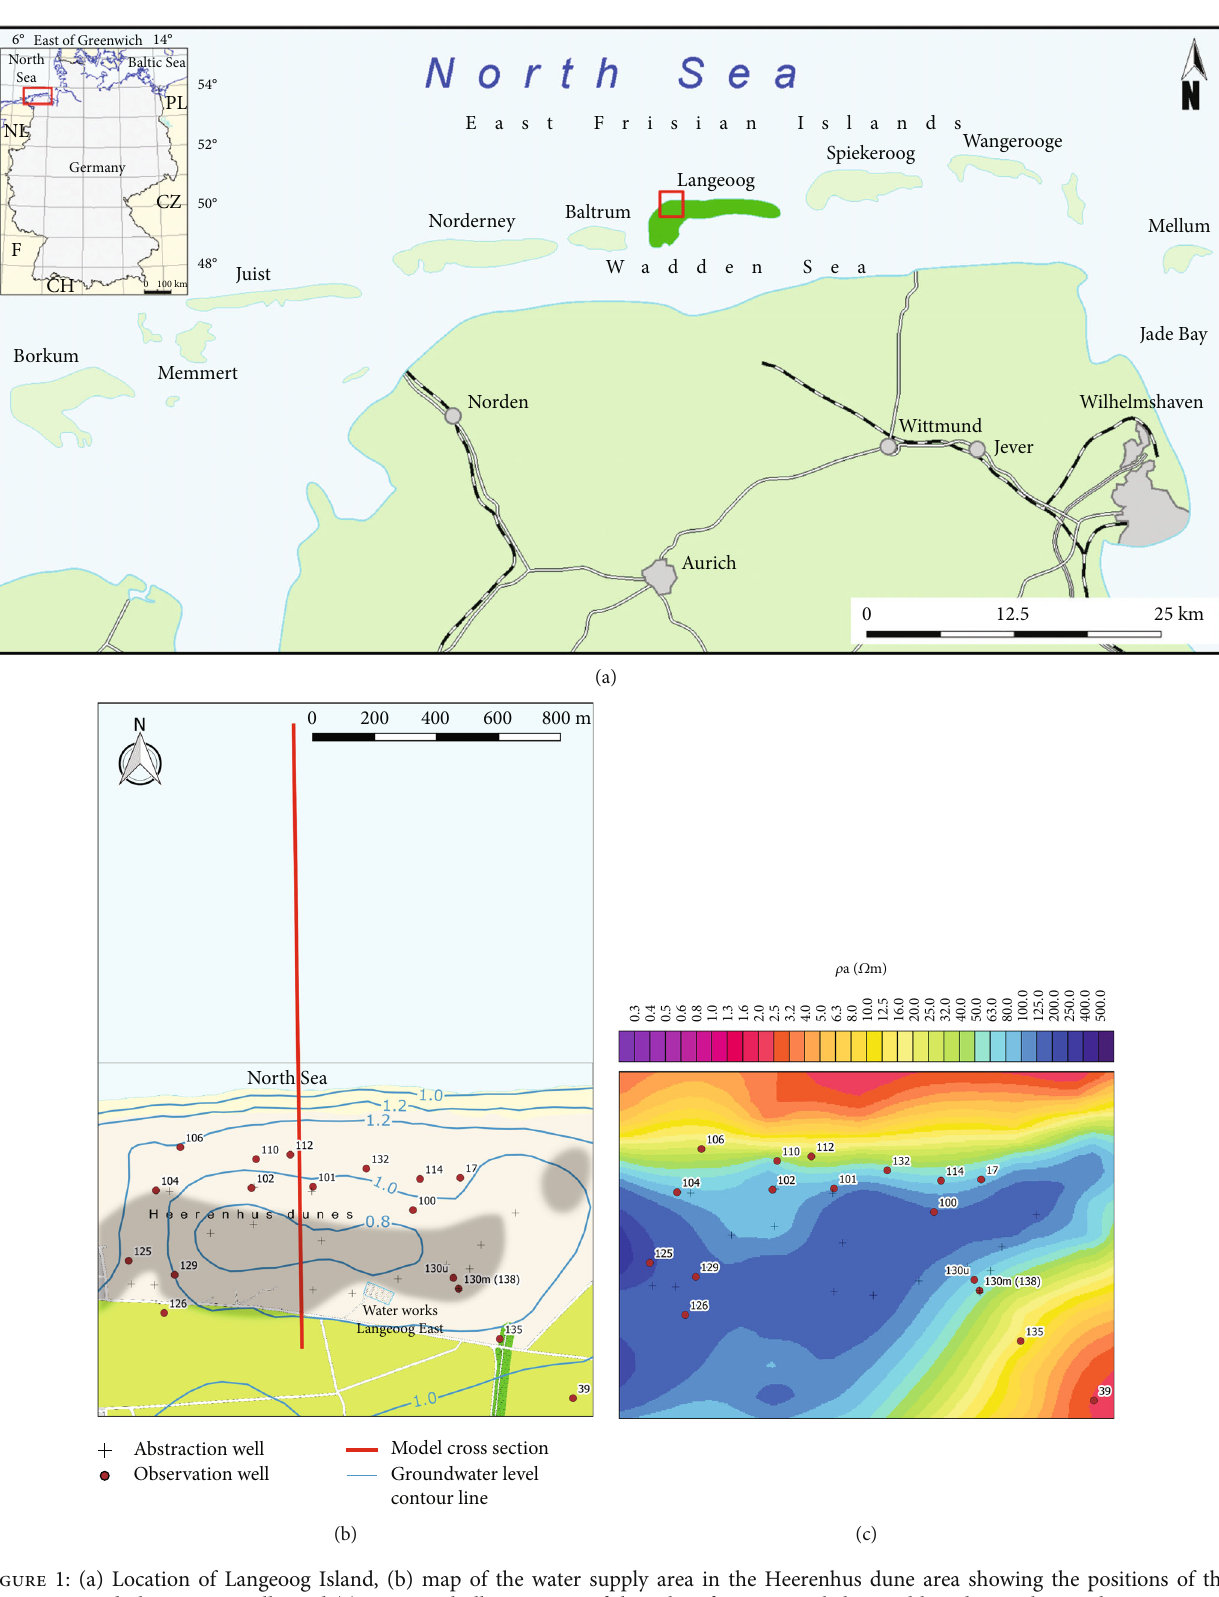
Figure 1: (a) Location of Langeoog Island, (b) map of the water supply area in the Heerenhus dune area showing the positions of the abstraction and observation wells, and (c) apparent bulk resistivity of the subsurface at 10 m below msl based on airborne electromagnetic measurements [22]. Blue lines in (b) represent the groundwater level elevation above msl during the summer of 1996, and the red line shows the projection of the model cross section. The shaded areas enclose the locations where Costabel et al. [23] found either no indication for the presence of the aquitard or found it to be < 4m thick. See their Figure 11 for the elevation of the top of the